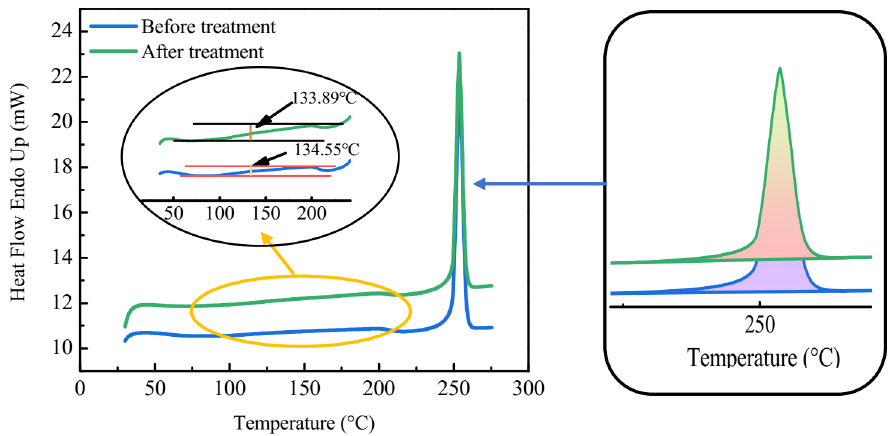
Figure 5. DSC curves of the polyester fabrics before and after